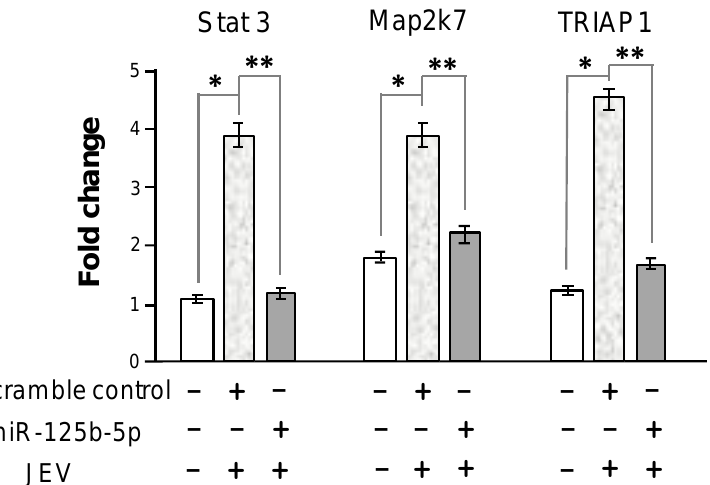
Figure 6. MiR-125b-5p targeted the six predicted genes, as demonstrated in luciferase reporter assays. Diagrams of the dual-luciferase reporter plasmids (pmirGLO vector; Table S3) and the microRNA (miRNA) are shown on the top. The activity was evaluated by the insertion of miRNA target sites at the 3′-UTR of the firefly luciferase gene (luc) and Renilla luciferase acting as a control reporter for normalization. The deletion of the miRNA target site was used as a negative control. BHK-21 cells were co-transfected with 100 ng of a luciferase reporter construct containing a gene target or the seed sequences deleted in conjunction with 0.5 nM of the miR-125b-5p mimic or the scramble miRNA as a negative control. After 24 h, cells were lysed for a dual-luciferase assay. Data are shown as means ± SD ( n = 3). *: p -value < 0.05; **: p -value < 0.01; ***: p -value < 0.001 compared with the scramble control and analyzed by Student’s t -test.